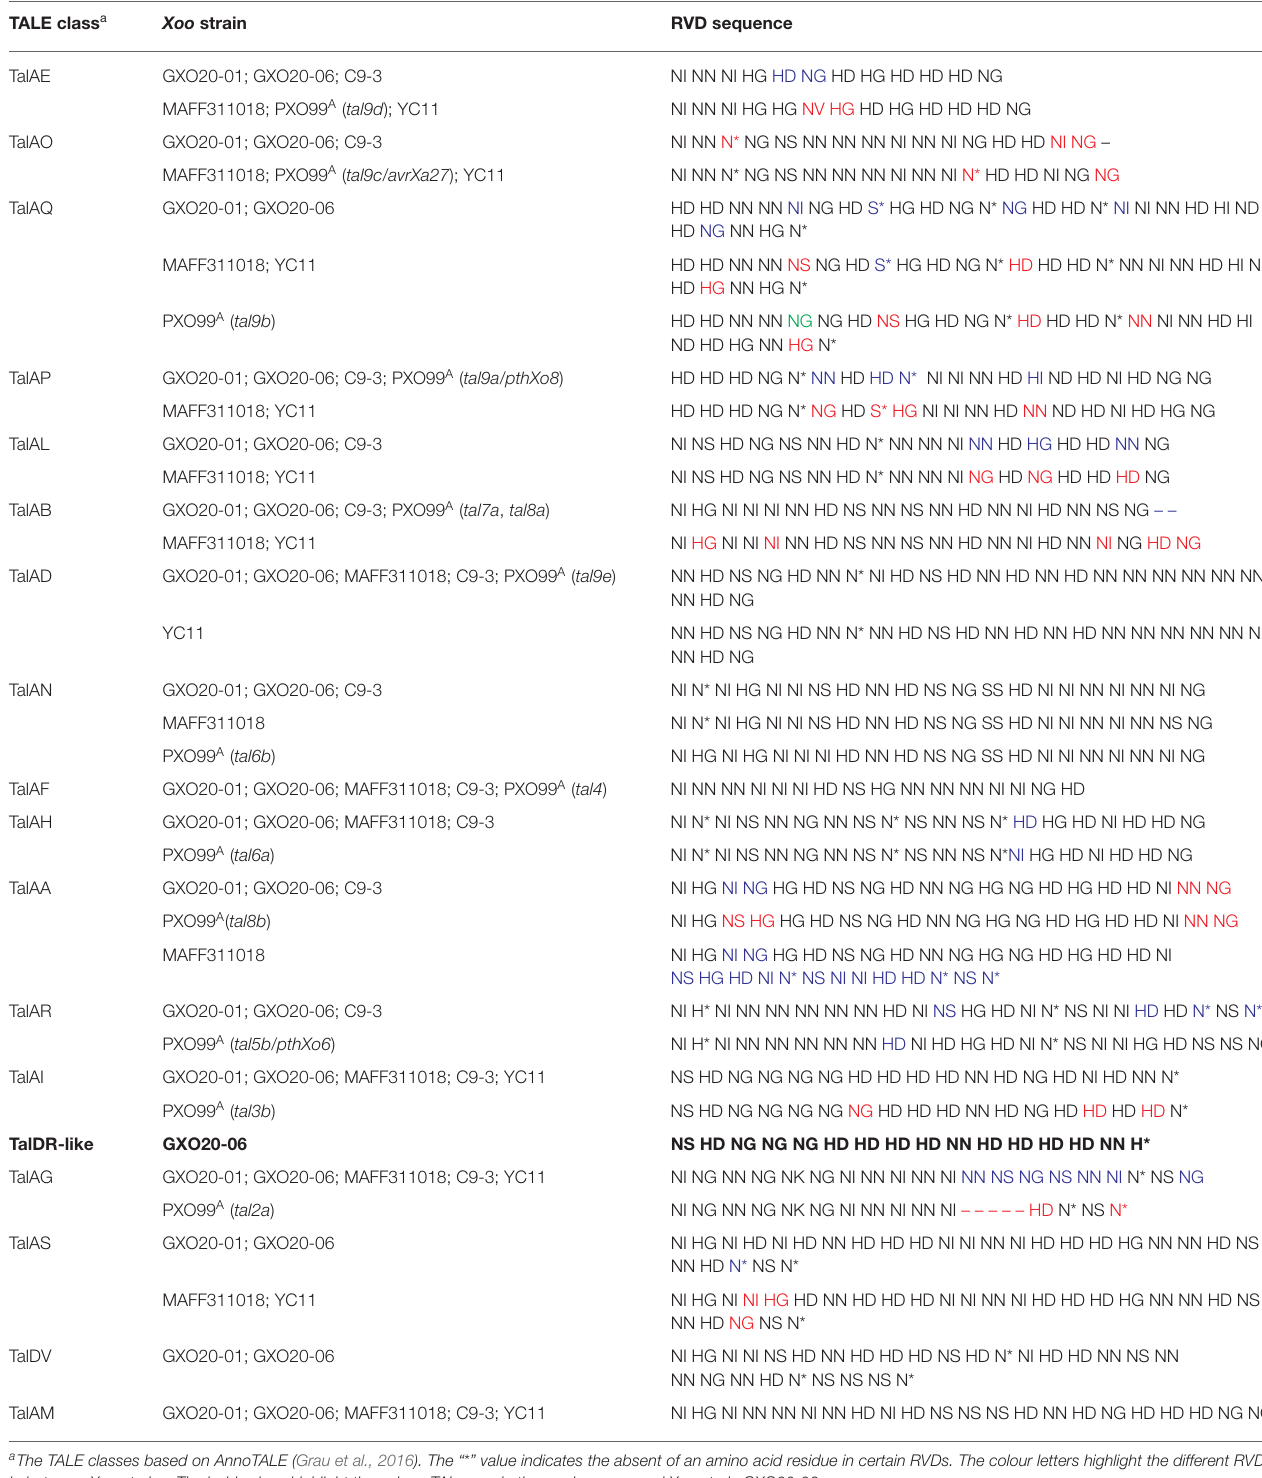
TABLE 4 | RVD sequences in TALEs of Xoo strains GXO20-01 and GXO20-06. TALE class